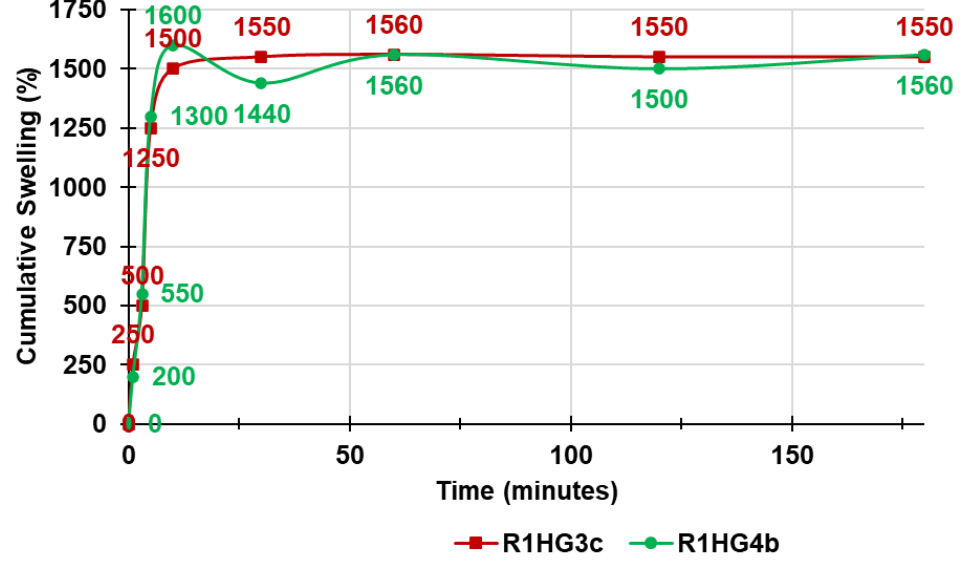
Figure 13. Cumulative swelling ratio percentage curves of R1HG-3c and of R1HG-4b. Bars of error not detectable in the graph. not detectable in the